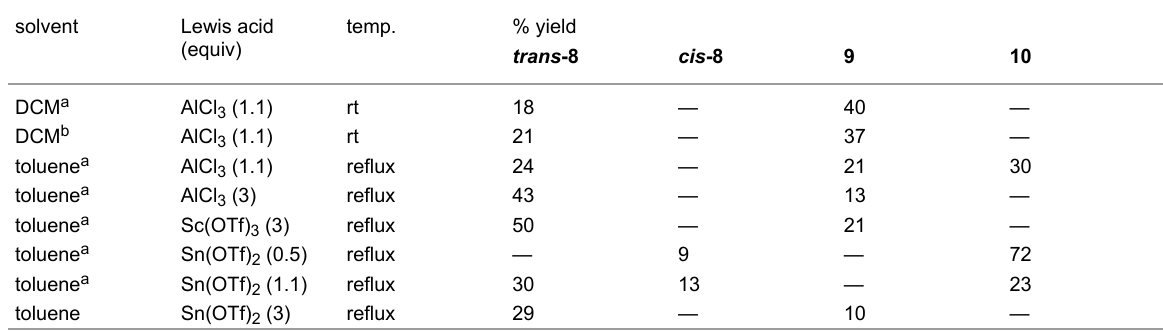
Table 1: Overview of the Lewis acid mediated folding reactions of 3 .